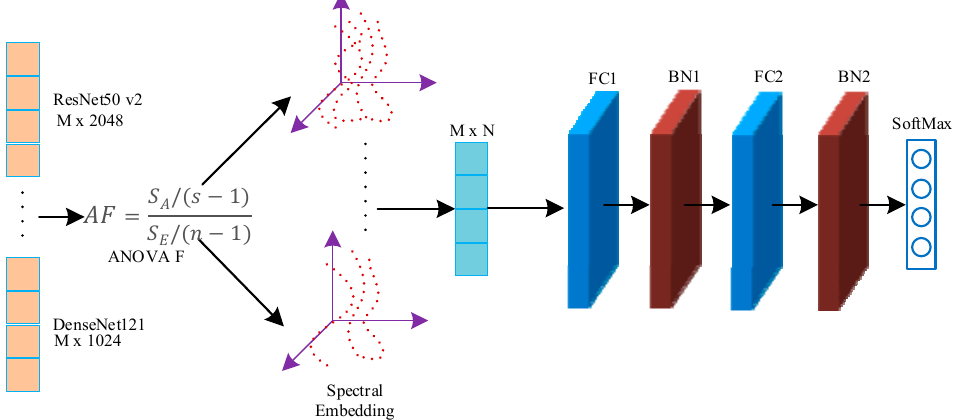
Figure 5. Framework diagram of the deep network convolutional feature fusion subnet based on ANOVA F-spectral embedding. The loss function of this subnet was the categorical cross-entropy function, the optimization algorithm was stochastic gradient descent, and the learning rate was: 0.1 for epochs 0–60, 0.01 for epochs 61–120, 0.001 for epochs 121–180, and 0.0001 for epochs 181 and above. In the Figure 5, M represents the number of samples in the training set, and n represents the feature-length of each sample after dimension reduction and fusion. FC stands for Full Connection layer, BN stands for batch normalization layer, and s is the length of the column in the depth feature matrix (the feature length of the sample, n is the length of the